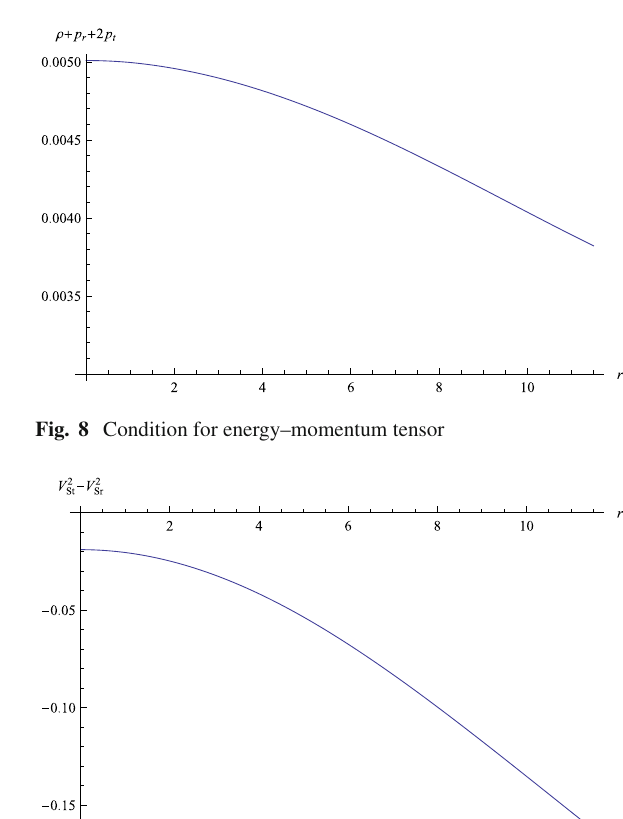
Fig. 7 Condition for energy–momentum tensor